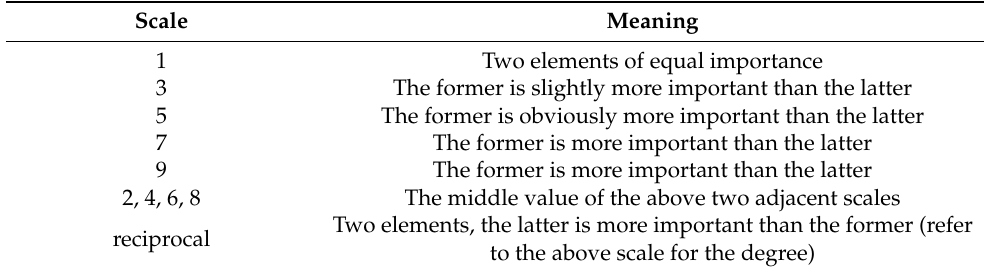
Table 1. Scale definition of AHP judgment